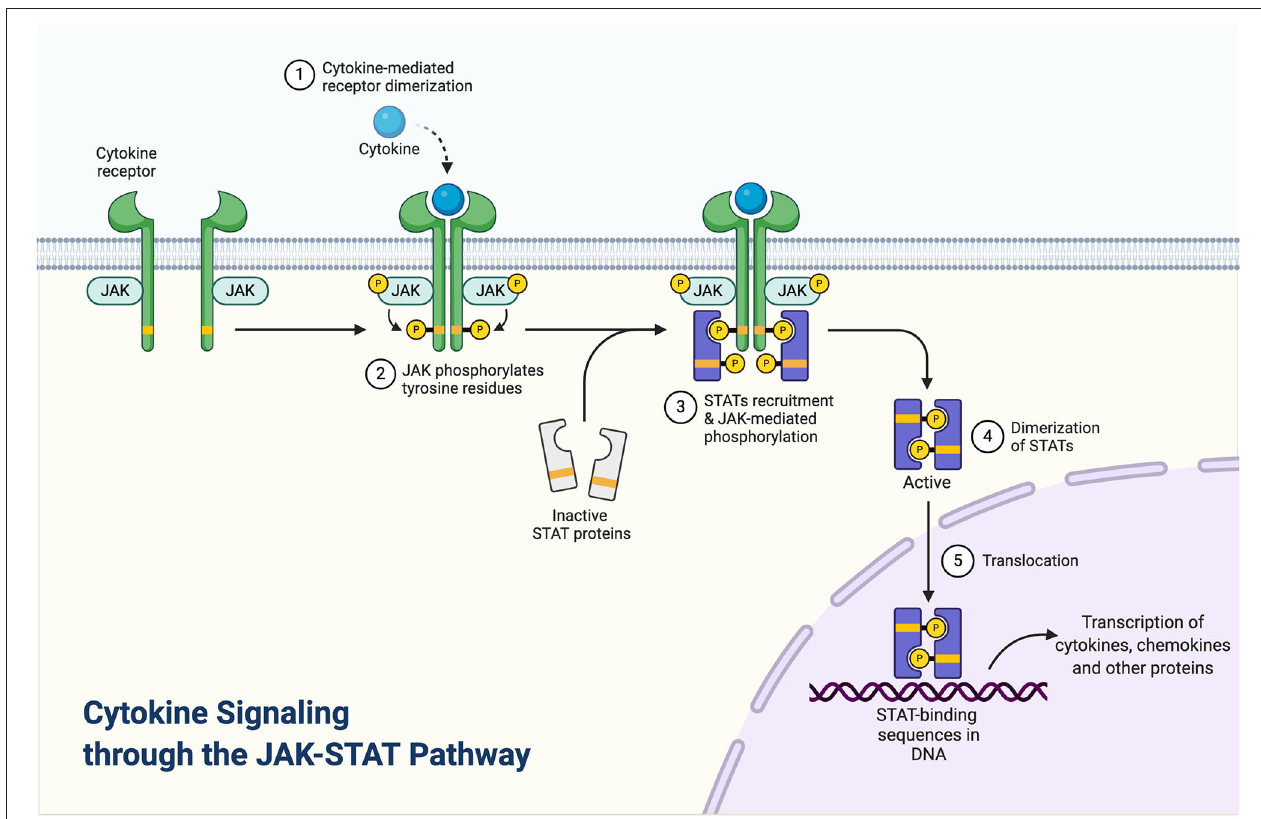
FIGURE 1 | Cytokine signaling through the JAK-STAT pathway. Adapted from “Cytokine signaling through the JAK-STAT pathway,” by BioRender.com (2020). Retrieved from